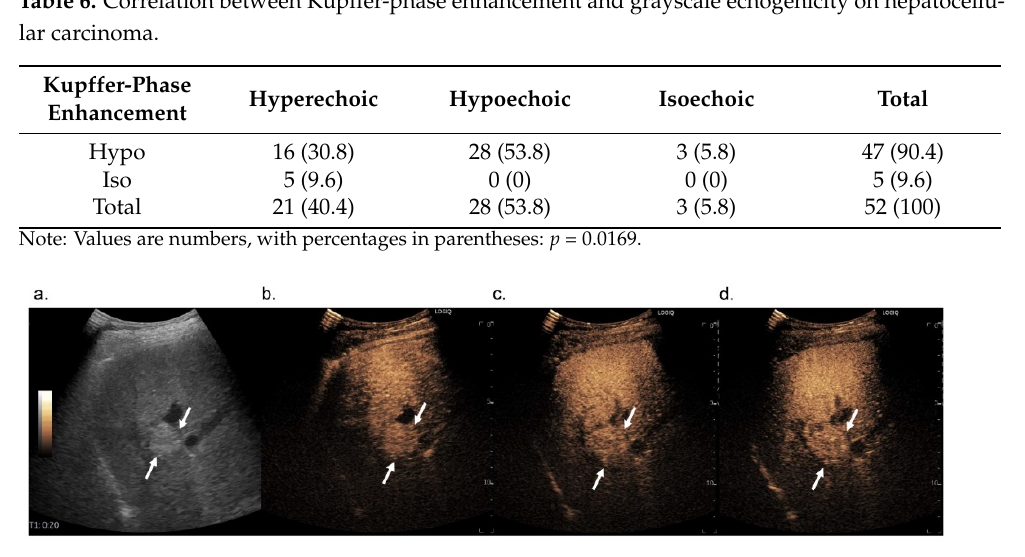
Table 7. Correlation between Kupffer-phase enhancement and hepatocellular carcinoma differenti- ation.